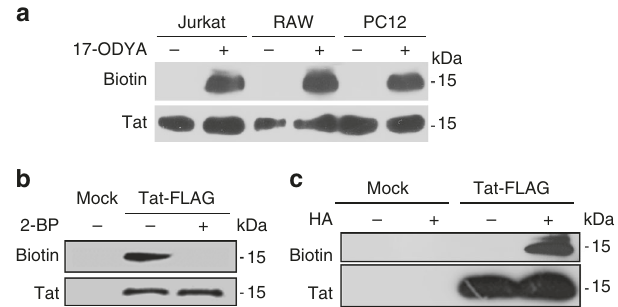
Fig. 1 Tat is palmitoylated in T-cells, macrophages and neuron precursors. a T-cells (Jurkat), macrophages (RAW 264.7) or neuron precursors (PC12 cells) were labeled overnight with 17-ODYA and Tat-His 6 in lipid-free medium before cell lysis, Tat-His 6 puri fi cation, biotin labeling of 17-ODYA using click chemistry and SDS-PAGE. The blot was fi rst incubated with avidin-peroxidase to detect biotin, then with anti-Tat antibodies. b PC12 cells were transfected with Tat-FLAG before overnight labeling with 17- ODYA, anti-FLAG immunoprecipitation, and click chemistry. When indicated 100 µ M 2-bromopalmitate (2-BP) was present during labeling with 17-ODYA. c PC12 cells were transfected with Tat-Flag before anti-Flag immunoprecipitation and acyl-biotin exchange. Hydroxylamine (HA) treatment is used to remove the acyl chain and enables to replace it with biotin for palmitoylation detection. Representative data from n =